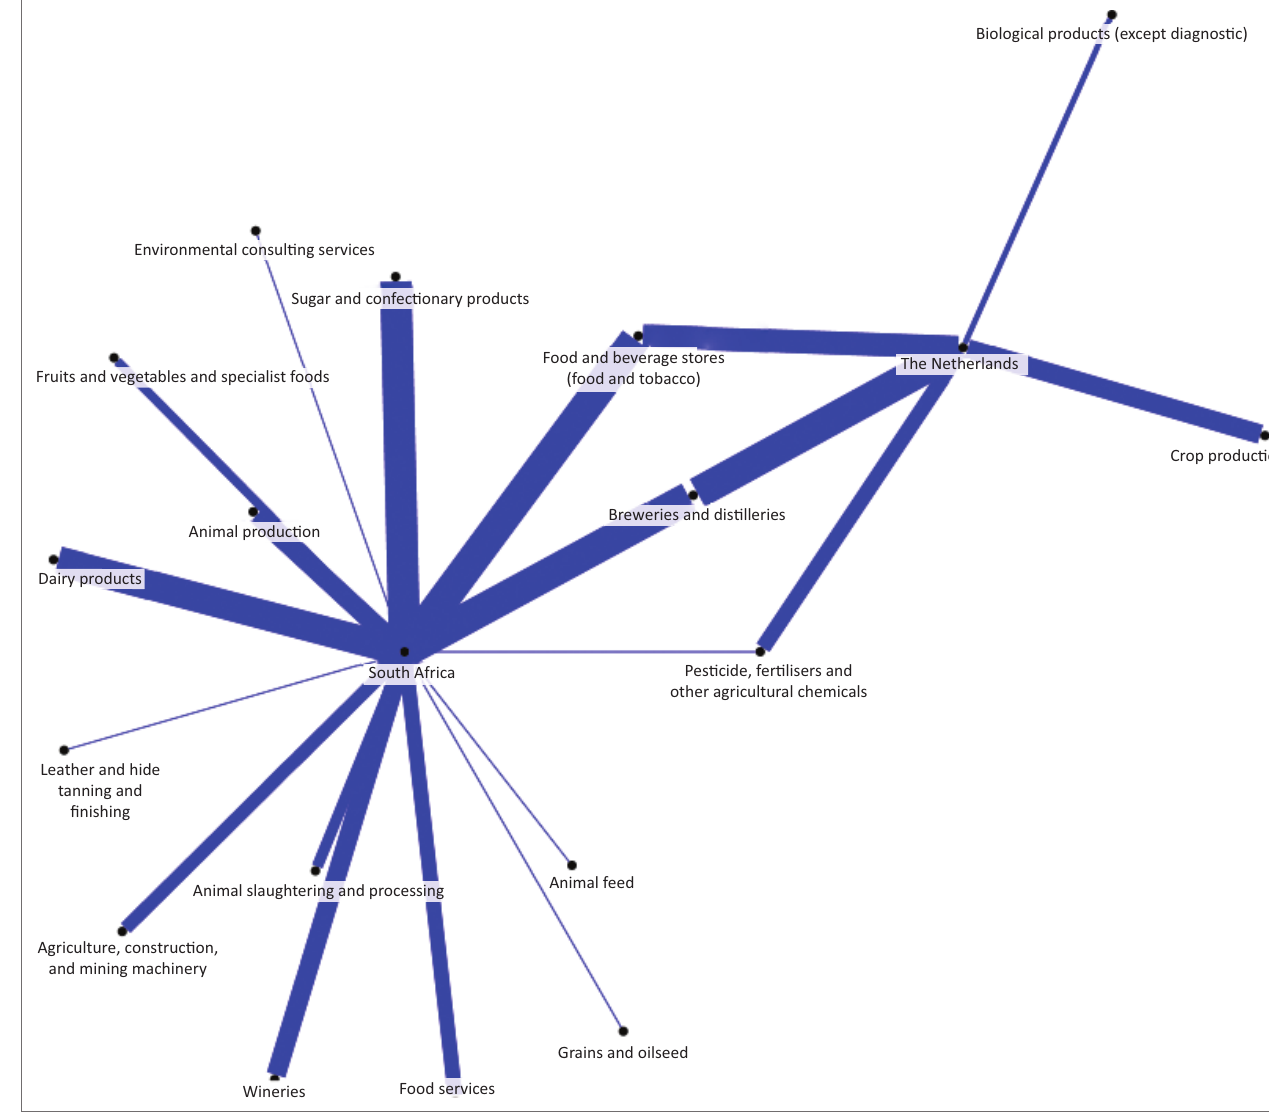
FIGURE 4: Foreign direct investment linkages in agriculture between the Netherlands and South Africa versus South Africa and